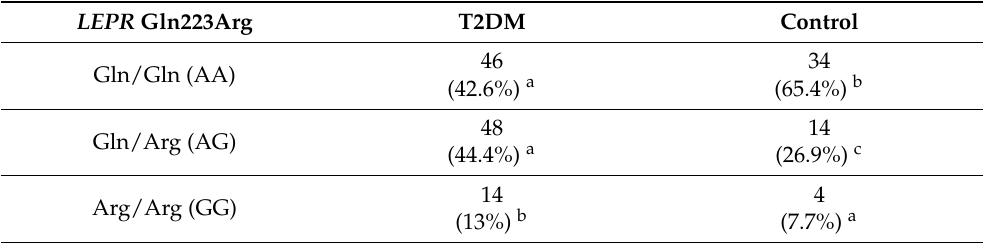
Table 1. Frequency of LEPR Gln223Arg genotypes in T2DM and control groups. LEPR